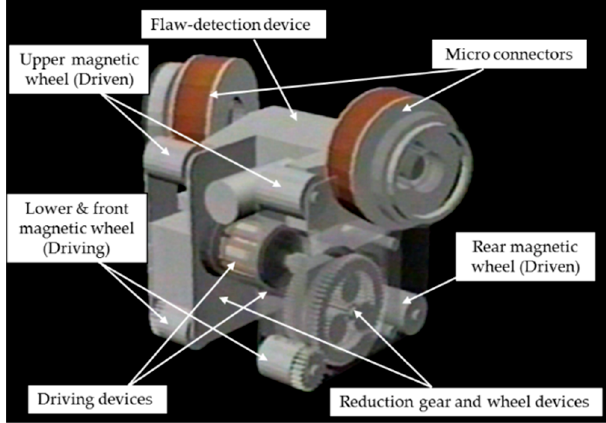
Figure 19. Configuration of a prototype of a magnetic wheeled microrobot with four types of functional devices: driving devices, reduction gear and wheel devices, micro connectors, and a flaw-detection device.